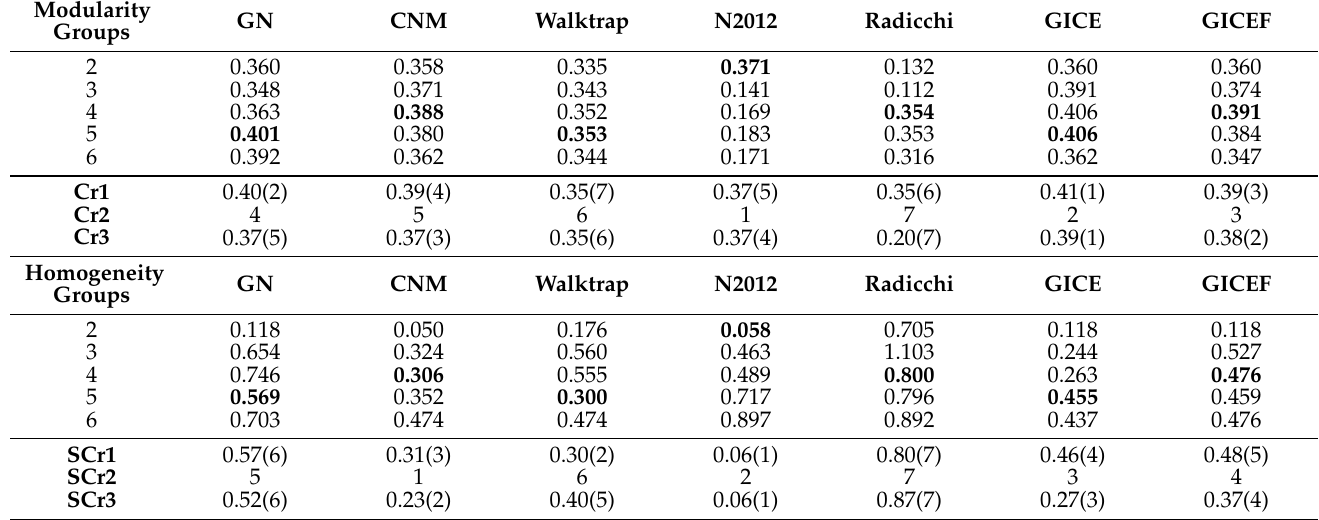
Table 2. Modularity and Homogeneity for partitions with k groups ( k = 2, . . . ,6) obtained using the GN, CNM, Walktrap, N2012, Radicchi, our GICE and its fast version (GICEF) for the karate club network. The criteria values are shown in